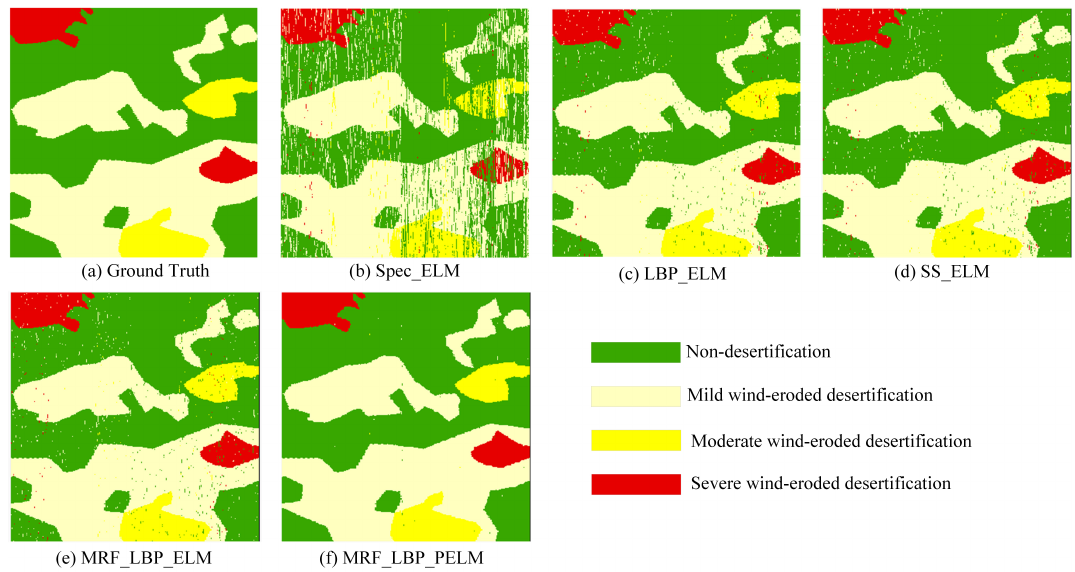
Figure 12. Comparison of visual interpretation results of different methods on wind-eroded desertifi- cation areas datasets.